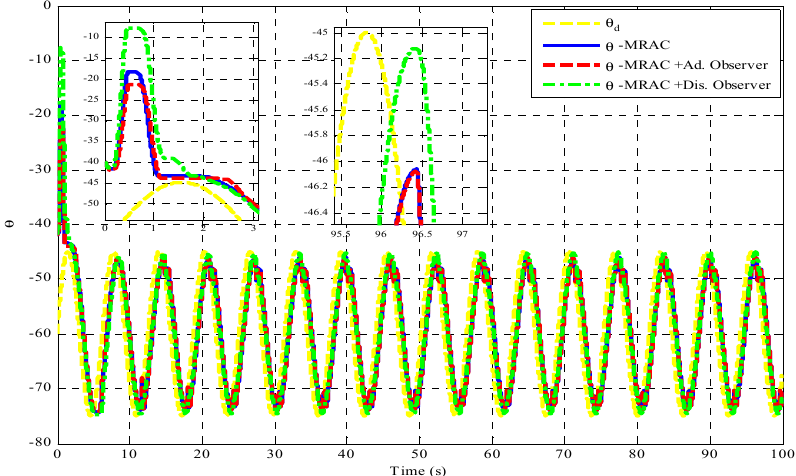
Figure 3. Exoskeleton knee assisted system position response for the three controllers.